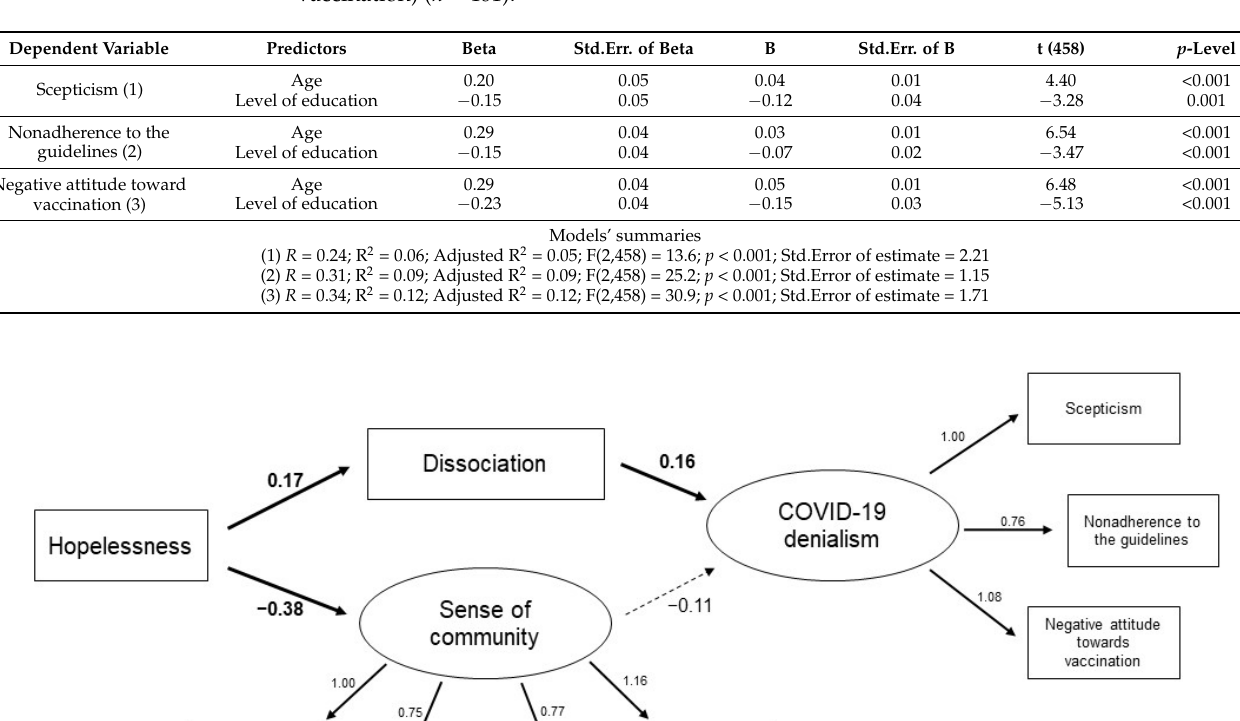
Table 3. Multiple regression analyses performed with age and level of education as predictors of COVID-19 denialism (scepticism, nonadherence to the guidelines, and negative attitude toward vaccination) ( n = 461).